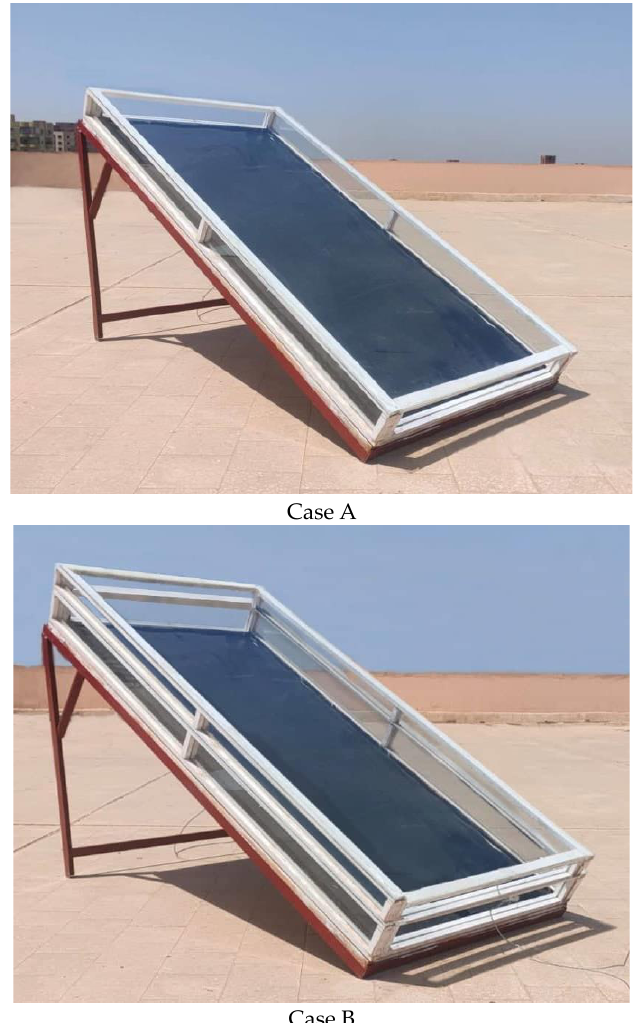
Figure 3. A photograph of the two FPSAH designs.